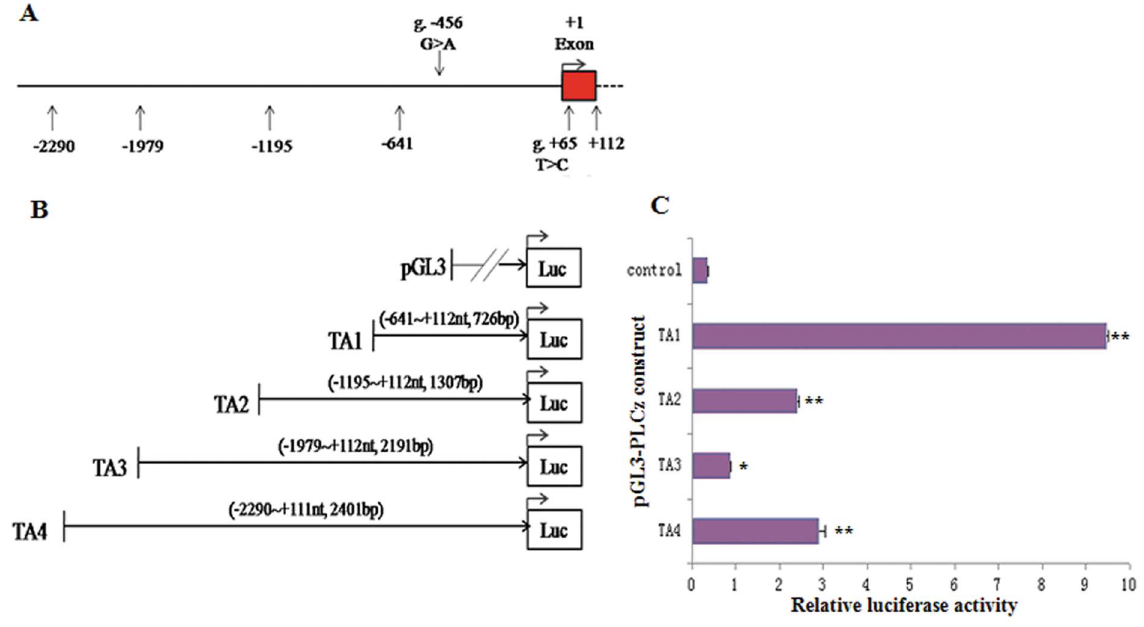
Figure 4. Scheme of the 5 9 -flanking region of PLCz gene and identification of the core promoter region. A. 5 9 -flanking region of bovine PLCz , as identified in the NCBI database. The base numbers are relative to the A of TSS. The red box represents exon 1. g. 2 456 G . A and g. + 65 T . C are located in the 5 9 -flanking region ( 2 2290 nt to + 111 nt) of PLCz gene. Other numbers represent primer positions for cloning reporter constructs. B. Fragments TA1, TA2, TA3, and TA4 were amplified by PCR to produce the reporter constructs; their positions and lengths are shown in parentheses. Each fragment with wild-type alleles was cloned into the pGL3-Basic vector. C. Relative luciferase activity of a series of truncated constructs in the PLCz 5 9 -flanking region, as measured by dual luciferase assays of MLTC-1 cells. For each construct, plasmid DNA extracted from 6 to 9 colonies was used. Results are presented as the average fold of firefly luciferase activity versus the Renilla control vector (mean 6 S.D., n =6 to 9). * indicates P , 0.05, ** indicates P , 0.01 vs. the pGL3 basic control (Ctrl).